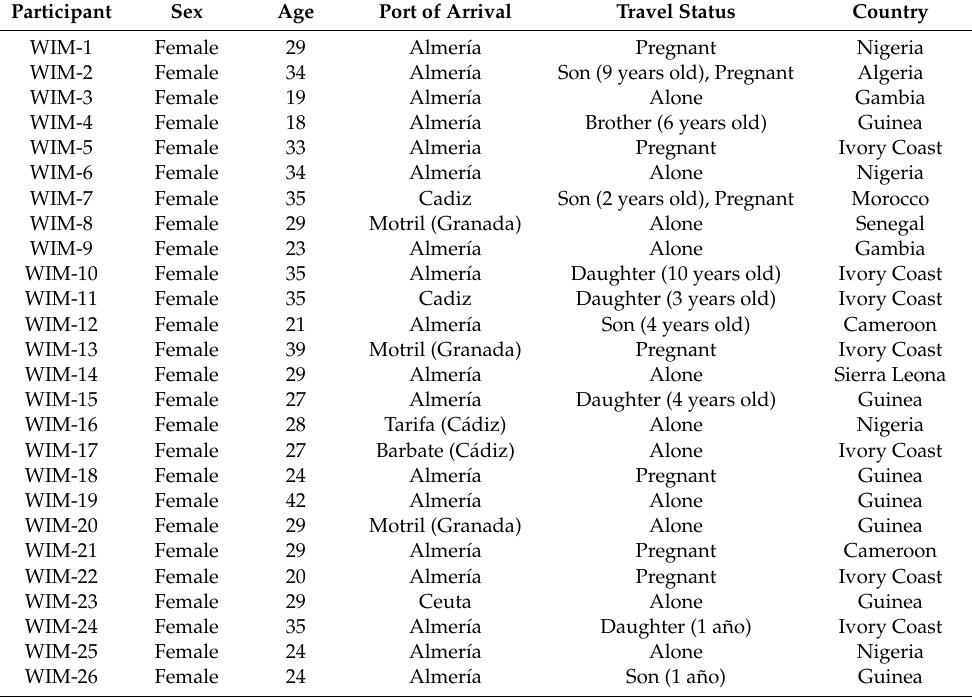
Table 1. Sociodemographic data of the participants ( N = 26).